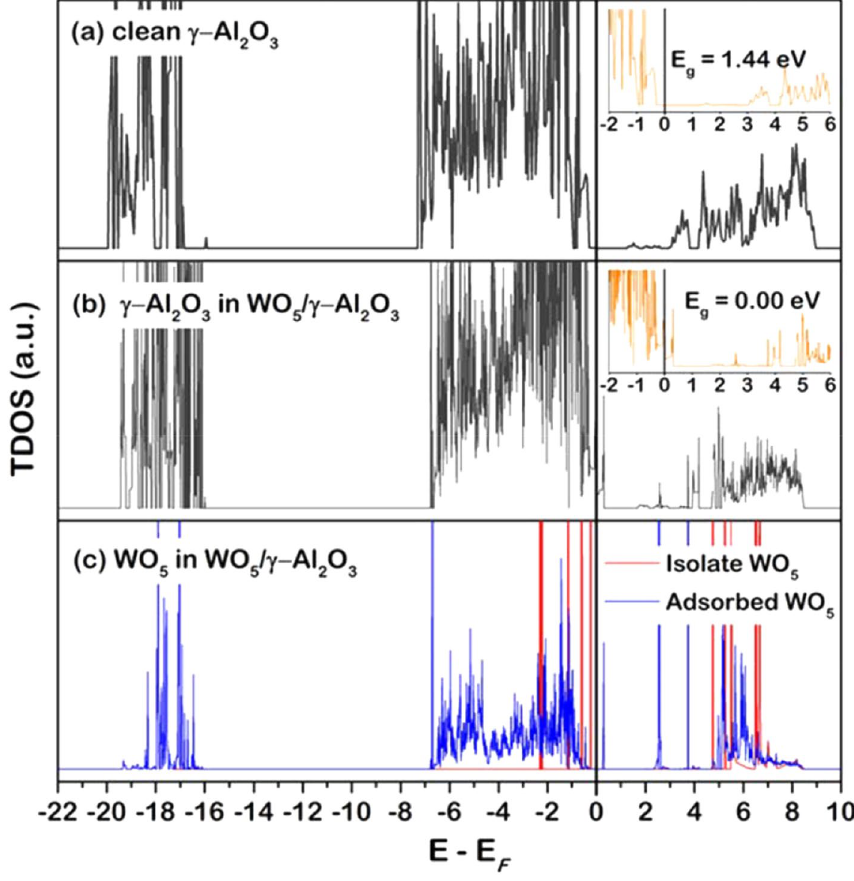
Figure 4. TDOS of the top layer ( a ) γ-Al 2 O 3 , ( b ) WO 5 /γ-Al 2 O 3, and ( c ) WO 5 species before and after adsorption (red and blue, respectively), where the inlet graphs in ( a ) and ( b ) are plotted in a specific range from − 2.0 to 6.0 eV to show the energy gap